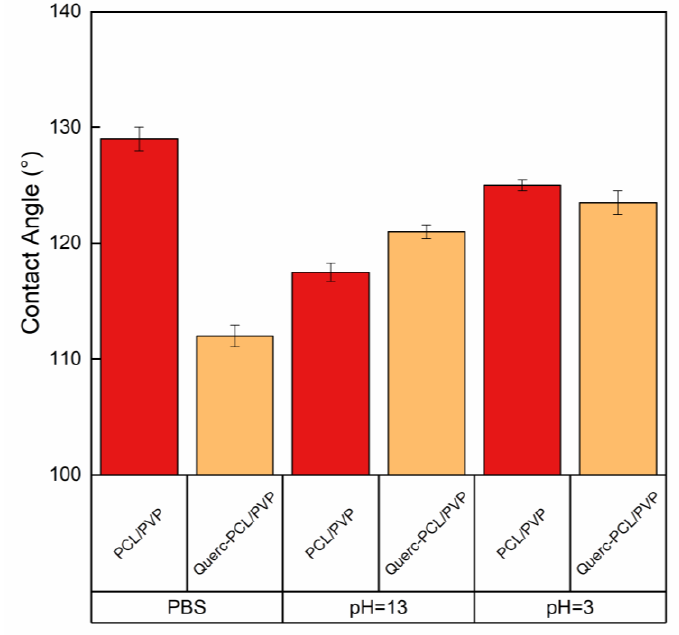
Figure 6. Contact angles values for PCL/PVP and Querc-PCL/PVP membranes.